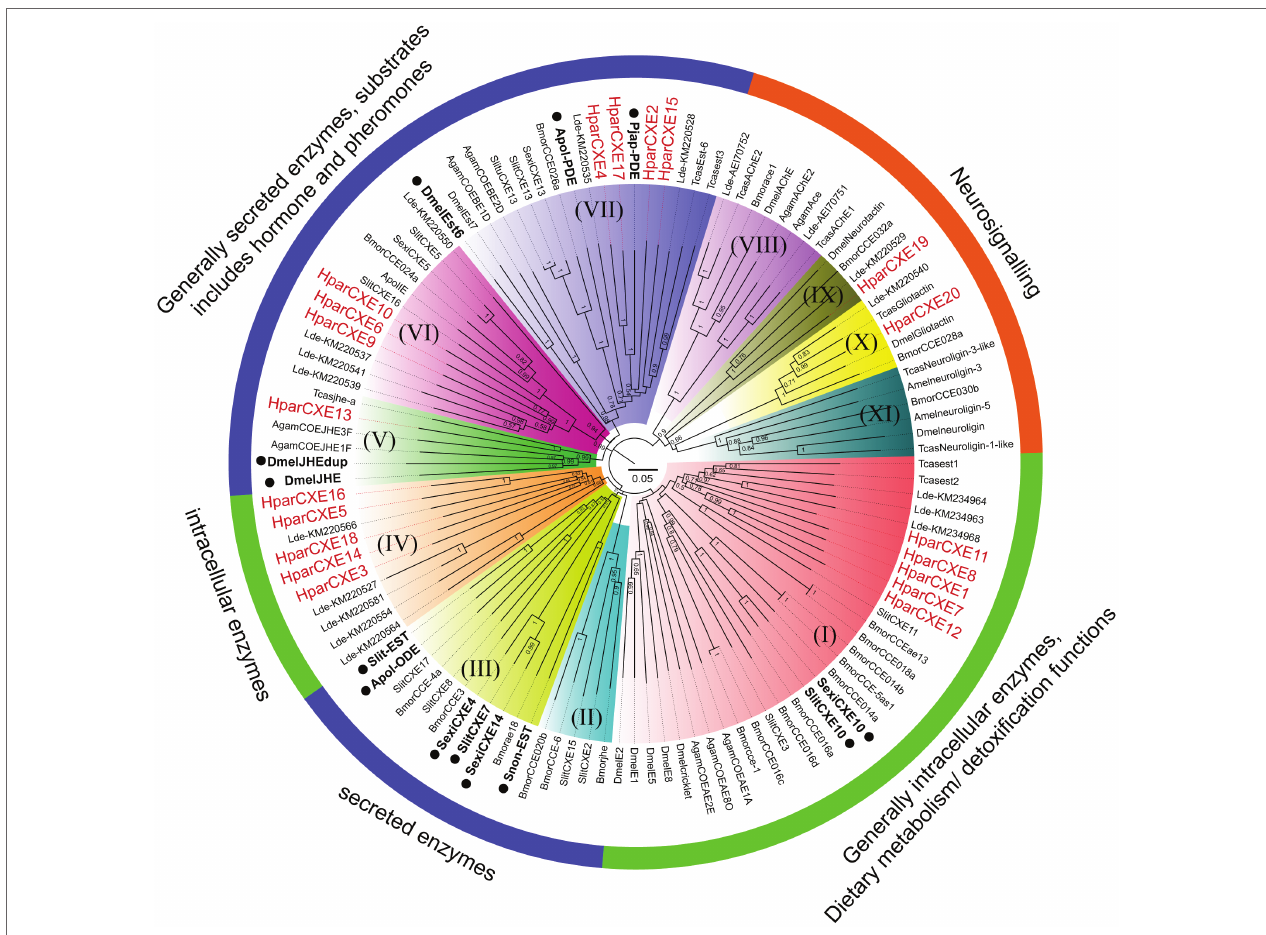
FIGURE 2 | Phylogenetic analysis of candidate CXEs between H. parallela and other species from Coleoptera, Lepidoptera, Hymenoptera, and Diptera . The neighbor-joining (NJ) trees were constructed using MEGA7.0 software with the p-distance model. All nodes have bootstrap support based on 1,000 replicates. CXEs are divided into secreted enzymes, intracellular enzymes, and neuro-signaling enzymes. (I) α -esterase clade. (II) Lepidopteran juvenile hormone esterases. (III) Mitochondrial, cytosolic, and secreted esterases. (IV) Coleopteran xenobiotic metabolizing enzymes. (V) Juvenile hormone esterase clade. (VI) Cuticular/antennal esterases. (VII) β and pheromone esterase clade. (VIII) AchE calde. (IX) Neurotactins. (X) Gliotactins. (XI) Neuroligins. Scale bar represents the 0.05 amino acid substitutions per site. Some CXEs functionally characterized as odorant-degrading enzymes or restrictively expressed in olfactory sensilla were marked with black